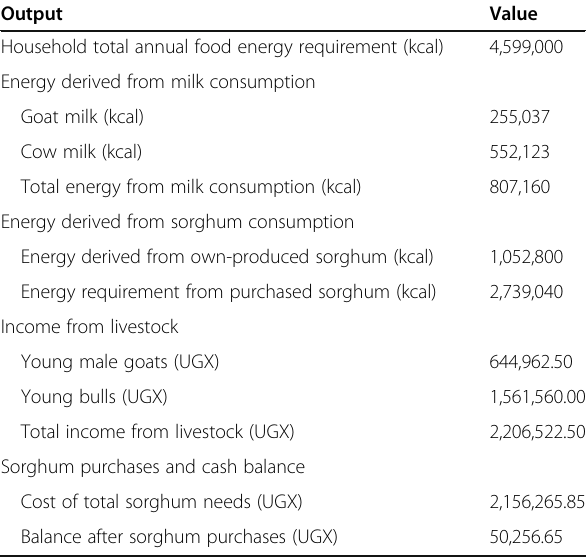
Table 3 Model outputs at livestock threshold of 3.3